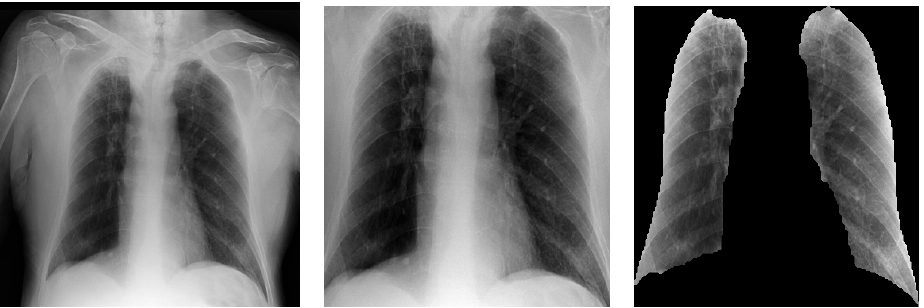
Figure 5. Examples of the three pre-processing schemes used. ( Left ): Raw image with equalization (taken from [17]). ( Centre ): Cropped image. ( Right ): Semantic segmentation of the